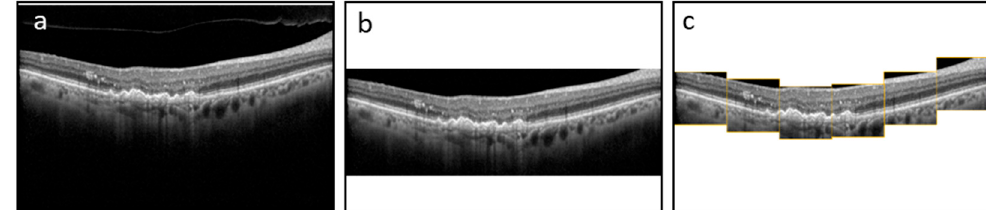
Figure 1. Three training image types—( a ) Full image; ( b ) Cropped image; ( c ) Patches.